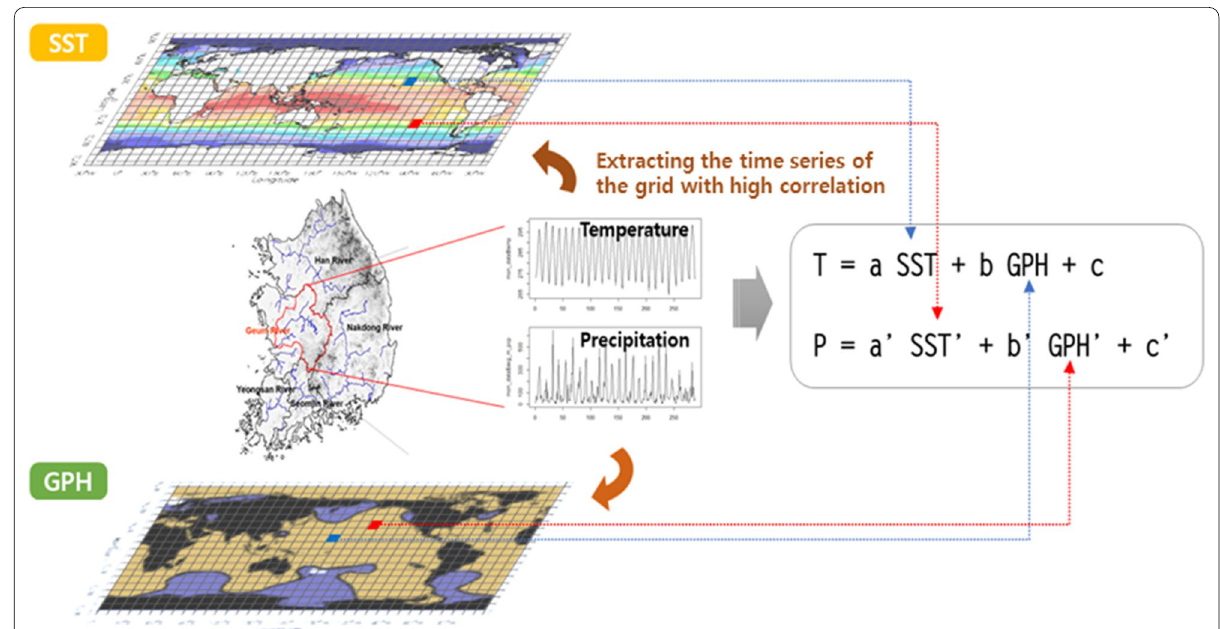
Fig. 4 Prediction model for temperature and precipitation based on the teleconnection between precipitation and temperature. SST is the sea surface temperature and GPH is the geopotential height. The prediction model was constructed by extracting the time series of the grid with the highest correlation. T and P denote the monthly mean temperature and precipitation, respectively; and a , b , c , a ’, b ’, and c ’ are the regression coefficients for the time series of the grid with the highest correlation in the SST anomaly and GPH